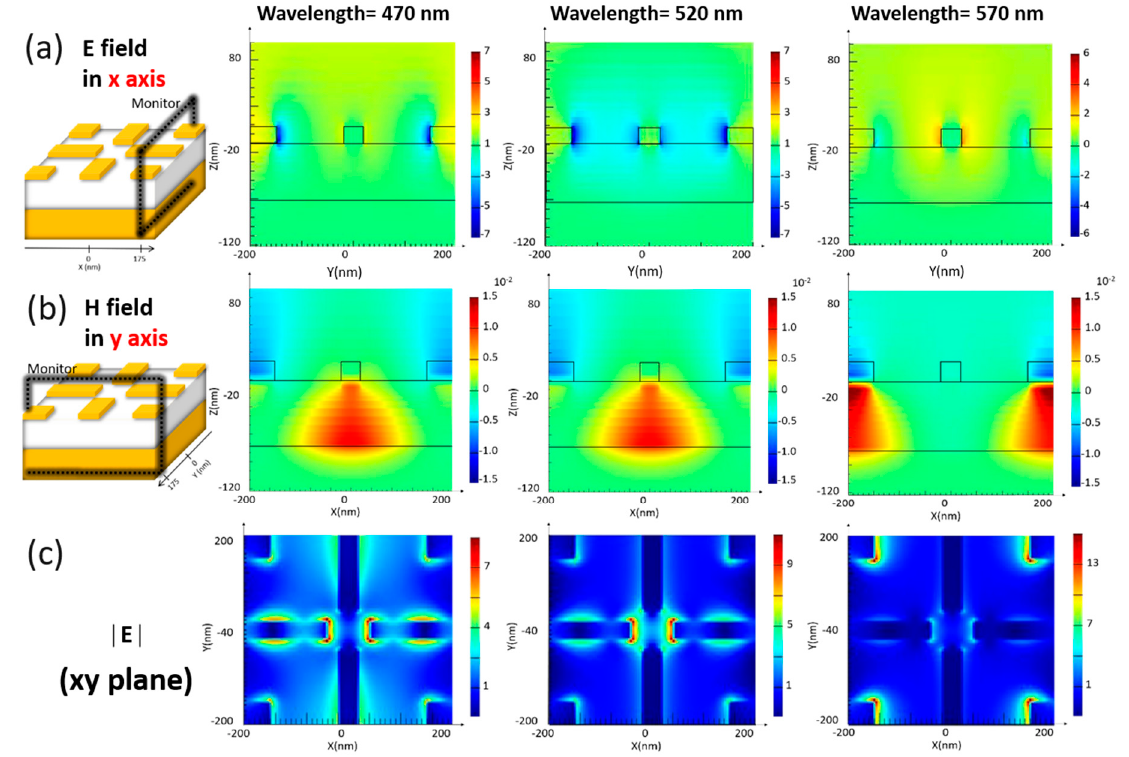
Figure 3. Examinations of ( a ) electric field in the x-axis, ( b ) magnetic field in the y-axis and ( c ) the total magnitude of electric field at resonances.